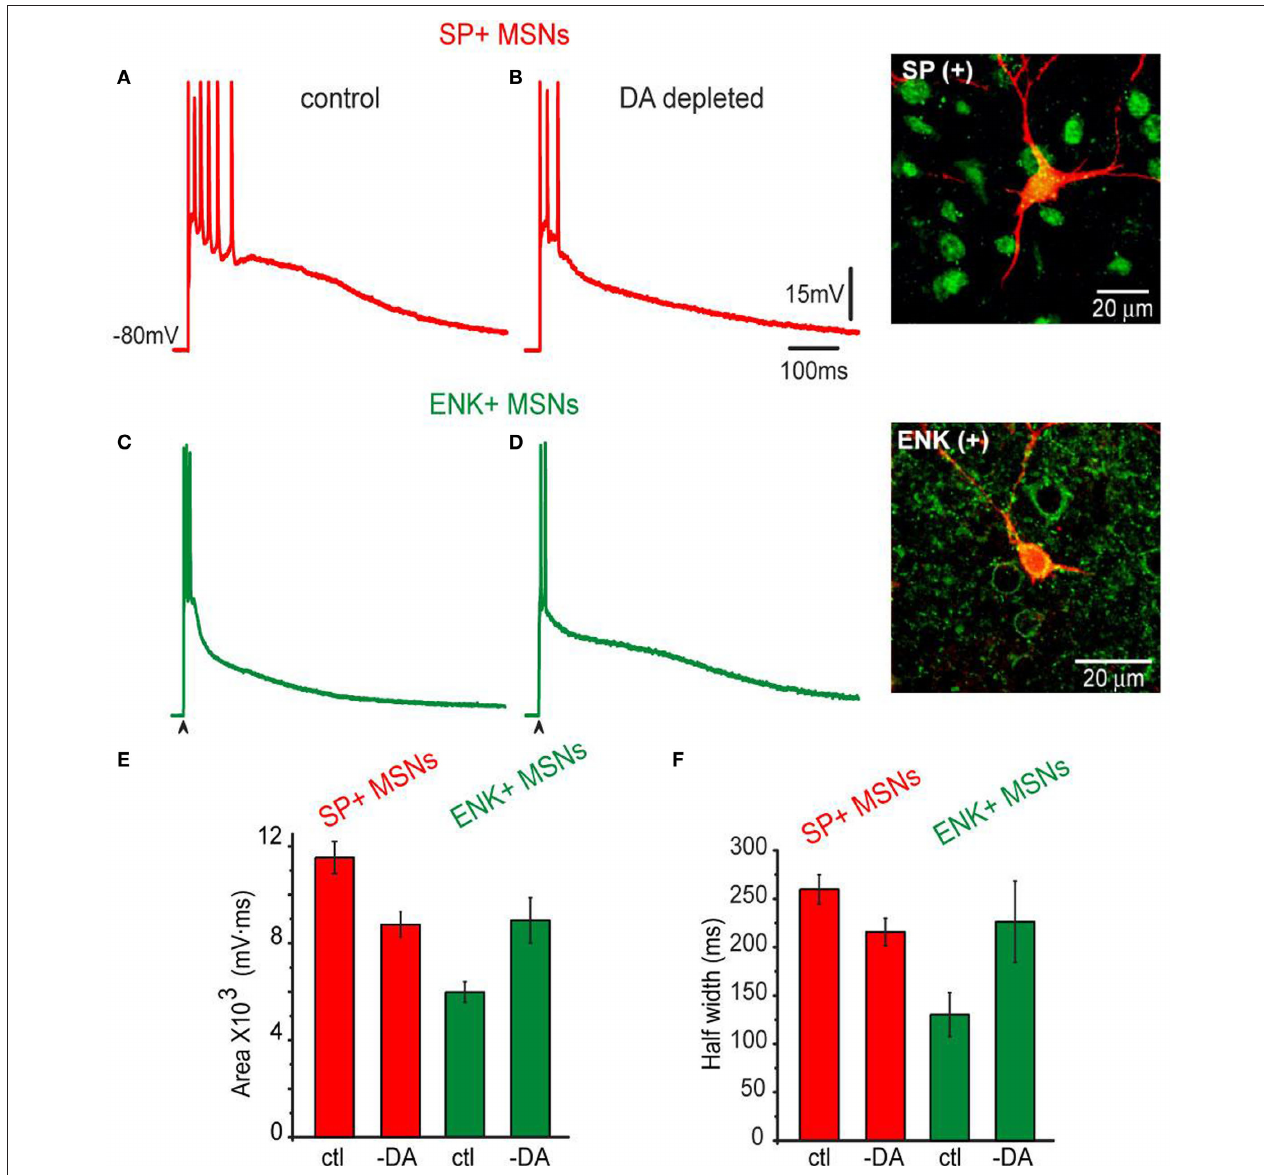
FiGure 5 | Corticostriatal synaptic responses of SP + MSNs and eNK + MSNs as modified by unilateral 6-OHDA lesions in the SNc. (A) Representative suprathreshold corticostriatal response of a SP + MSN recorded from an intact rat. (B) Representative suprathreshold corticostriatal response of a SP + MSN recorded in a 6-OHDA lesioned rat. Notice a response decreased in both amplitude and duration; the train of action potentials is substituted by